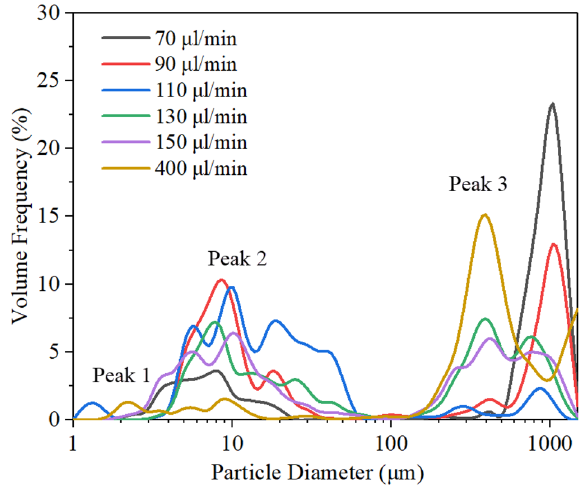
Figure 10. Aerosol droplet size distributions measured by laser diffractometry for different liquid flow rates with an SAW frequency of 30 MHz and input power of 6.62 W. Note that the Sauter mean diameter for the six analysed flow rates were 21.17 μm, 13.51 μm, 9.54 μm, 10.58 μm, 12.79 μm, and 32.51 μm,